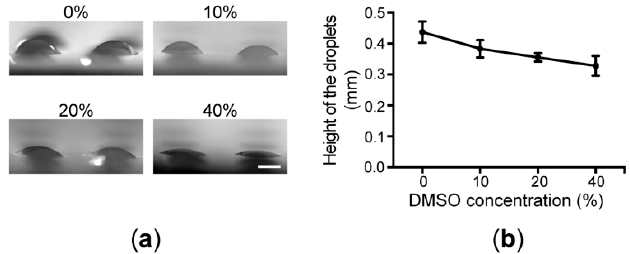
Figure 5. Nanoliter-volume liquid dispensing using the NanoCLD. ( a ) Side views of the dispensed droplets in microwells with different DMSO concentrations. ( b ) The correlation between the heights of the droplets and the DMSO concentrations (n = 20, scale bar: 400 μ m).